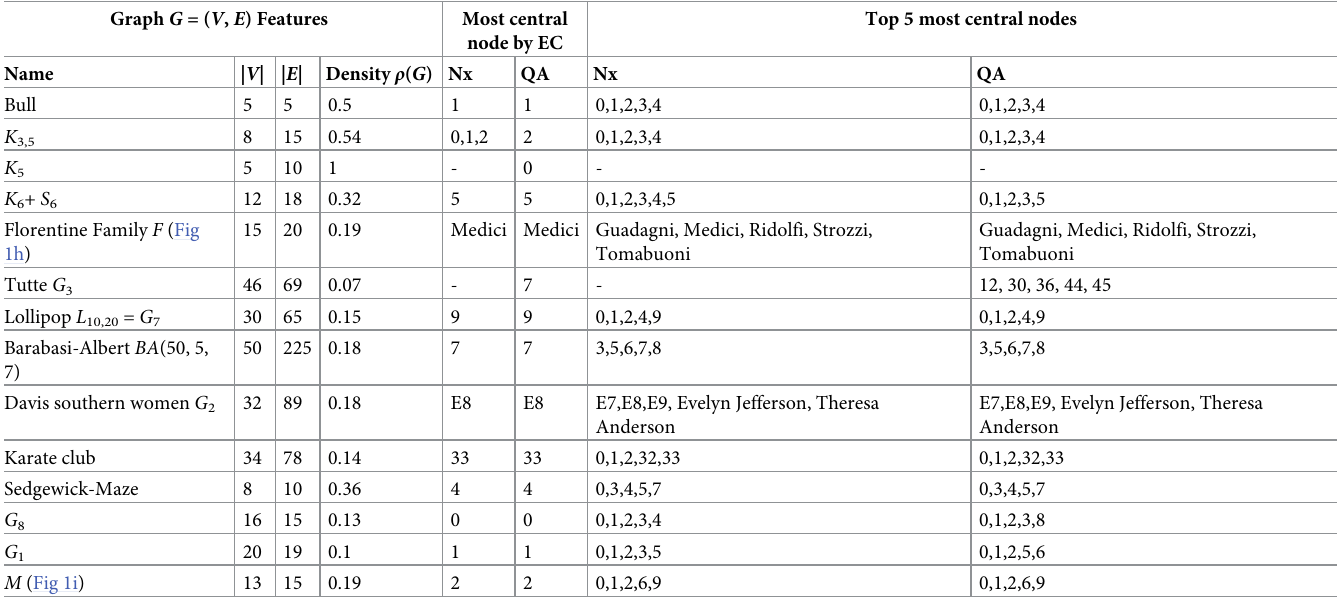
Table 1. Table of Networkx and QUBO results with τ = 1 and τ = 5. Graph G = ( V , E ) Features Most central